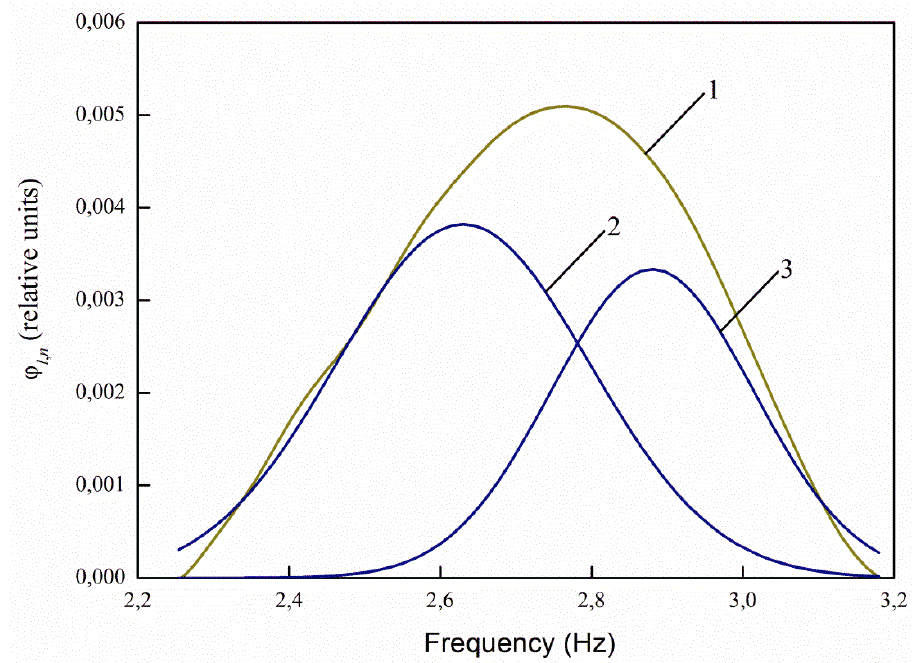
Figure 11. The spectral characteristic of the luminescence of infected wheat replacements at λ e, 2 = 362 nm (1), decomposition by Gaussian curves (2) and